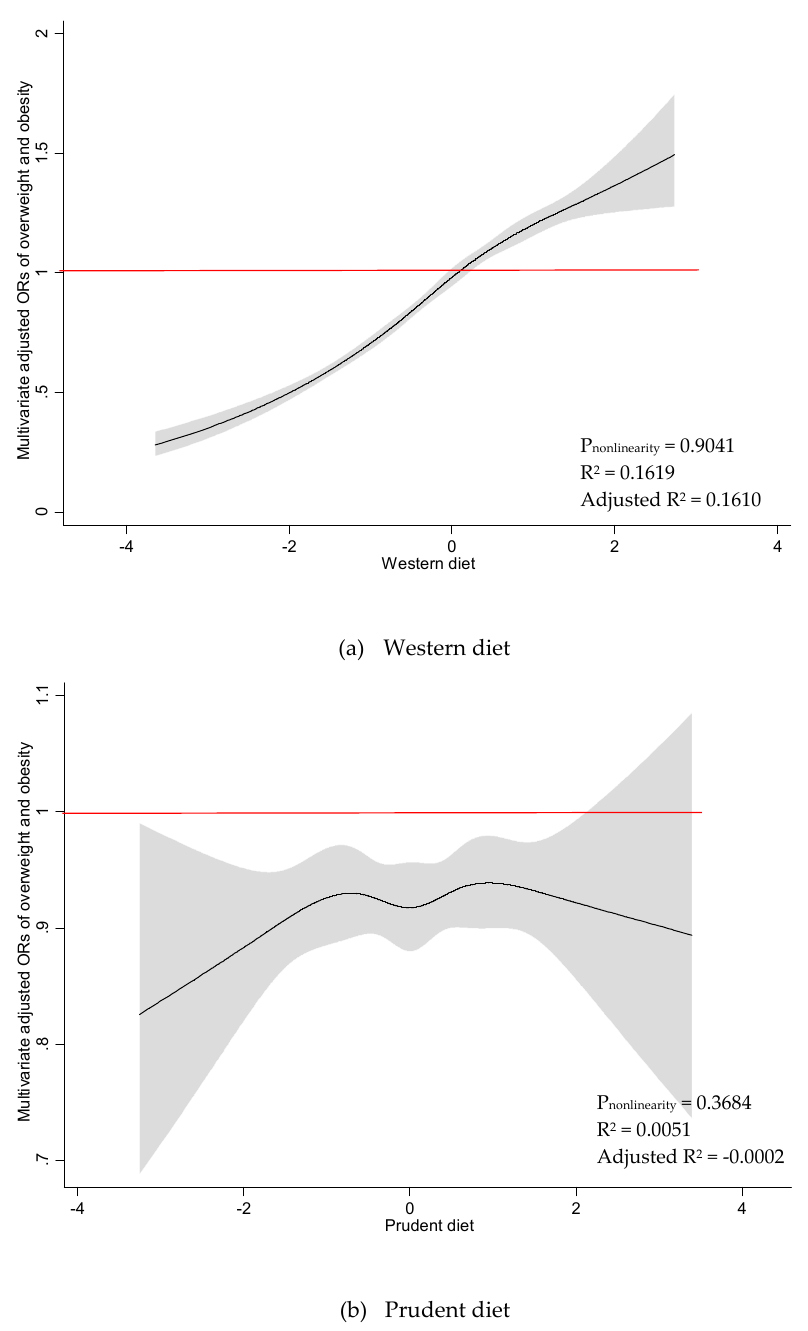
Figure 2. Restricted cubic spline plots between dietary patterns and multivariate adjusted odds ratio of overweight and obesity among women. ( a ) Western diet and ( b ) Prudent diet. Results obtained by multivariable logistic regression with restricted cubic splines with five knots. Solid black lines indicate odds ratio, and shaded areas indicate 95% CI.